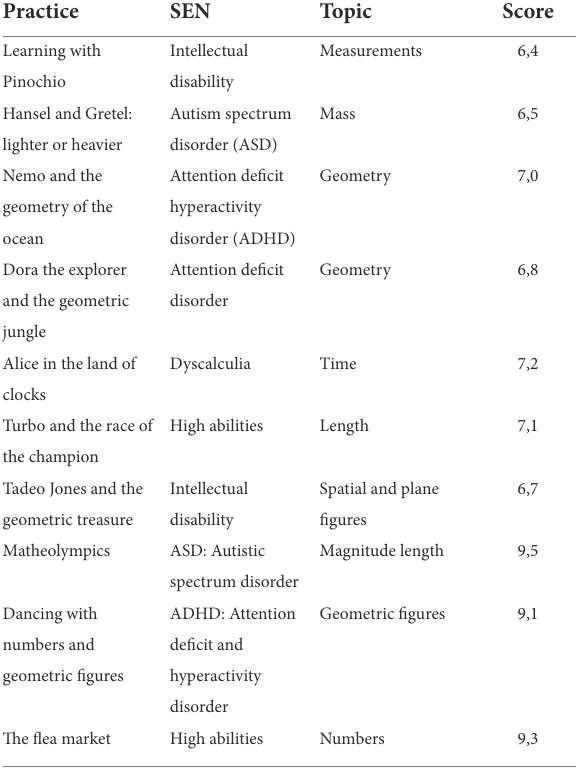
TABLE 3 Lessons developed for children with special educational